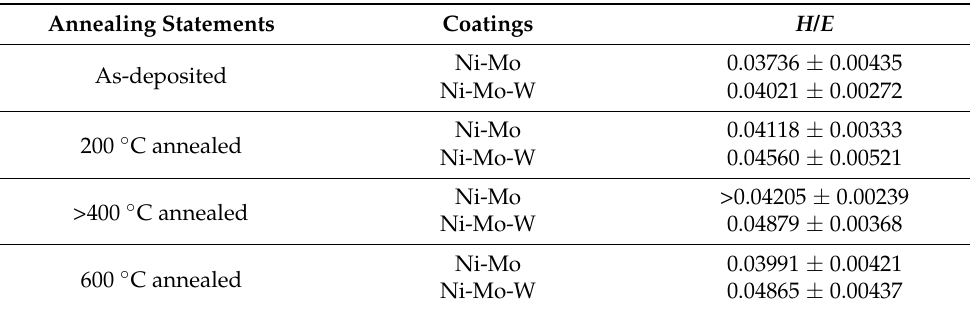
Figure 9. Friction coefficient and wear rate of Ni-Mo and Ni-Mo-W coatings with varying annealing temperatures. ( a ) friction coefficient; ( b ) wear rate. Table 2. The H/E ratio determined from the values of hardness and elastic modulus of as-deposited and annealed Ni-Mo and Ni-Mo-W coatings in Figure